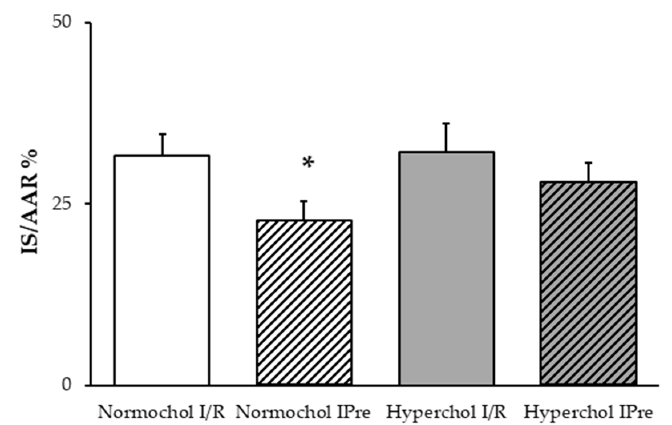
Figure 2. Infarct size values at the end of ex vivo heart perfusion. Hearts isolated from normo- and hypercholesterolemic rats were subjected to 35 min global ischemia and 120 min reperfusion (ischemia/reperfusion (I/R)) with or without ischemic preconditioning (3 × 5 min cycles of I/R applied before index ischemia; IPre). IS/AAR = infarct size/area at risk %. Data are expressed as mean ± SEM; n = 8. * p < 0.05 vs. corresponding I/R group. Normochol and Hyperchol refer to normo- and hypercholesterolemia, respectively.